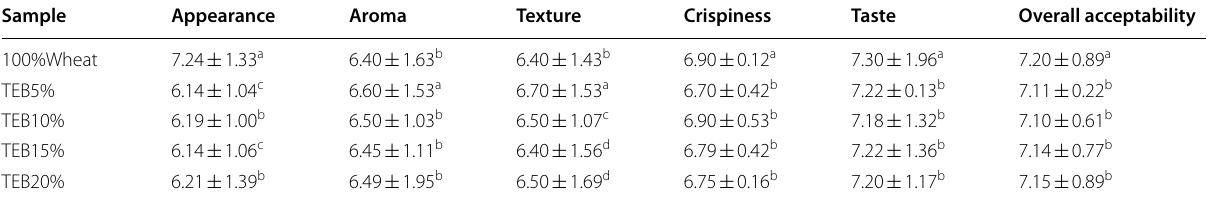
Means with different alphabetical superscripts in the same column are significantly different at P < 0.05 100% Wheat: 100% wheat flour